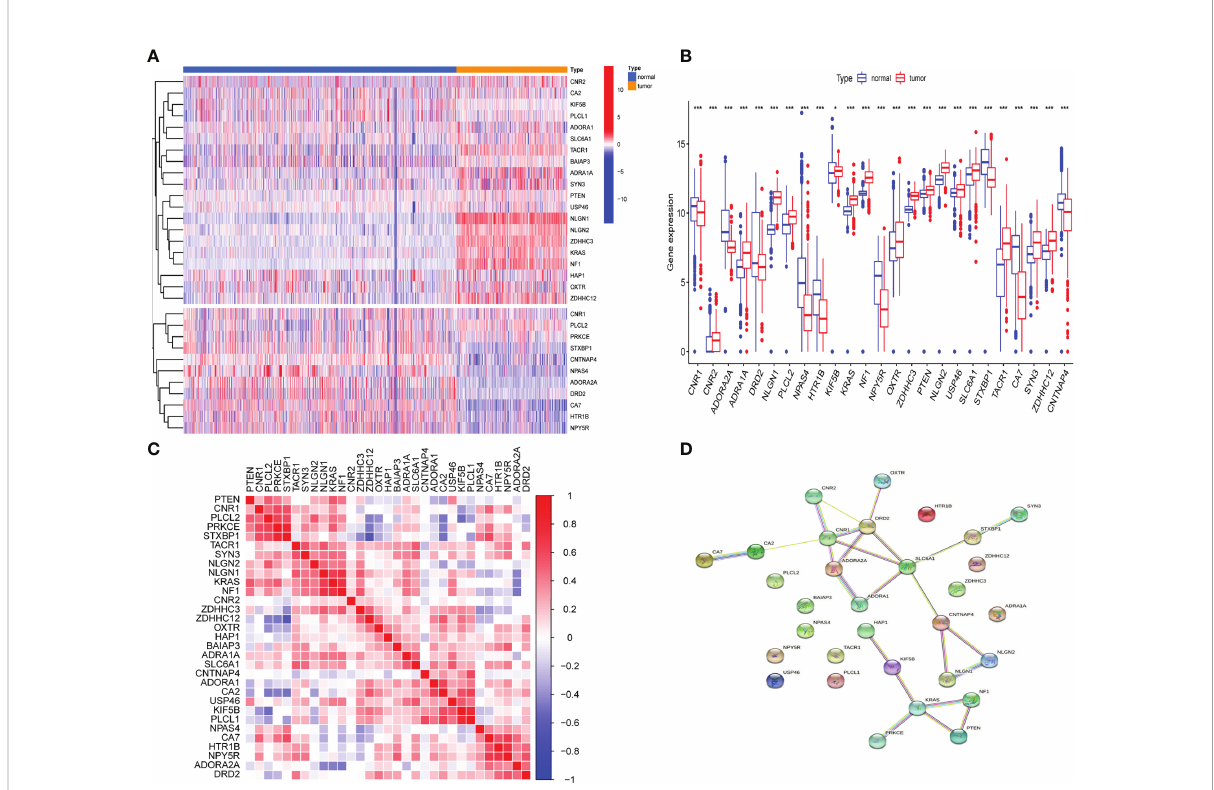
FIGURE 1 The genomic characterization of GABAergic synapse-related genes (GSRGs). (A) Heatmap for differentially expressed GSRGs; genes with red color are involved in positive regulation of GABAergic synaptic transmission, while genes with blue color mainly participate in negative regulation of GABAergic synaptic transmission. (B) Boxplot for differentially expressed GSRGs. (C) Correlation plot for GSRGs; red squares indicate positive correlation and blue squares indicate inverse correlation. (D) Protein – protein interaction network of GSRGs in the STRING database. ***p < 0.001, *p <